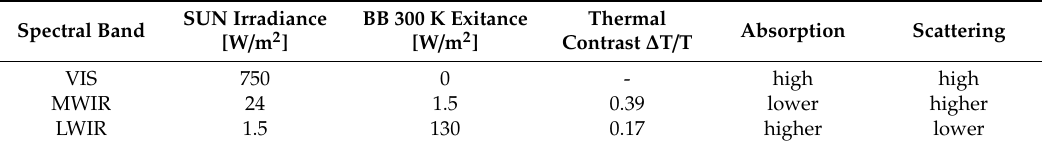
Figure 3. Thermal imager spectral band selection criteria: ( a ) Thermal image spectral sensitivity bands and atmospheric transmission windows; ( b ) blackbody exitance (around 300 K). Table 2. Properties related to thermal imager spectral sensitivity band selection.